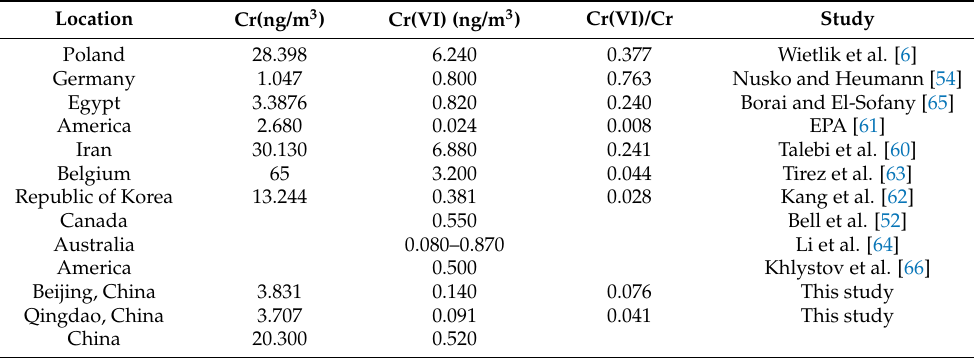
Table 6. Comparison of Cr and Cr(VI) Concentrations in this study with those in other